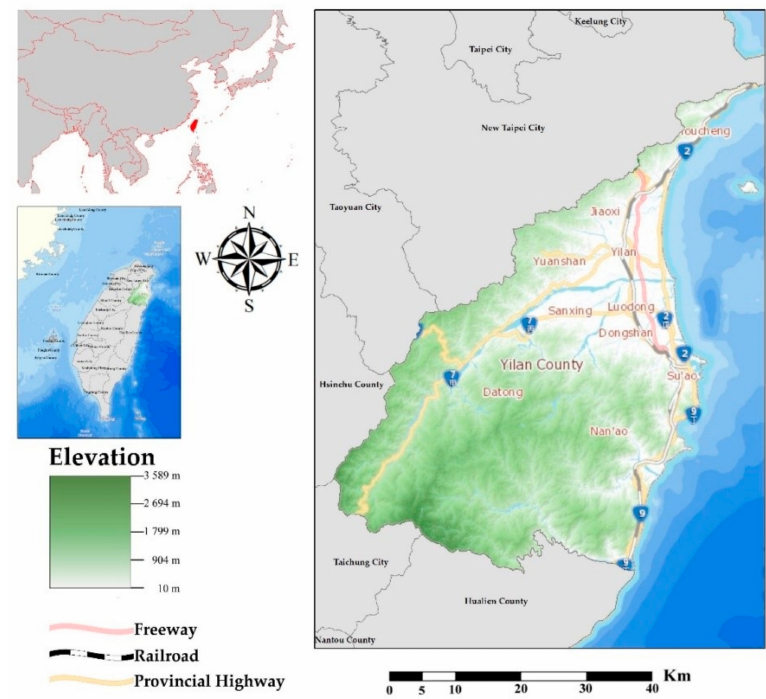
Figure 1. Case study